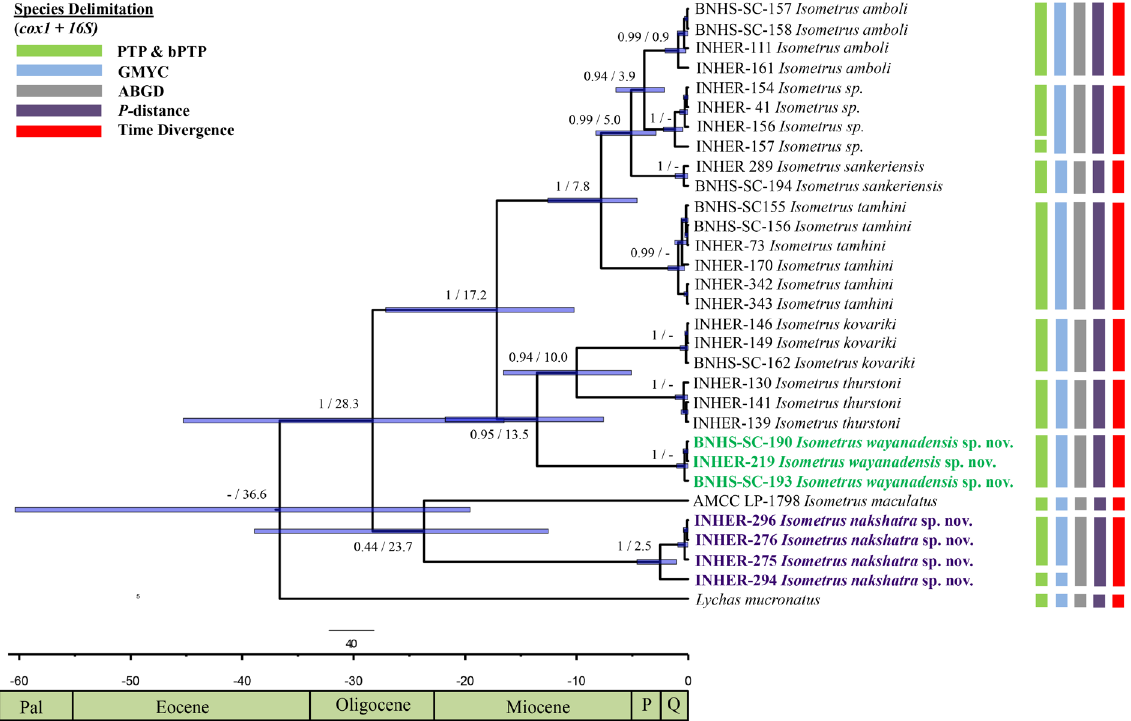
Fig. 1. Ultrametric tree showing phylogenetic relationships. Values along the nodes indicate Bayesian posterior probabilities and divergence dates in MY (PP/DD). Bars at the nodes indicate 95% HPD. Vertical bars represent delimitation analysis